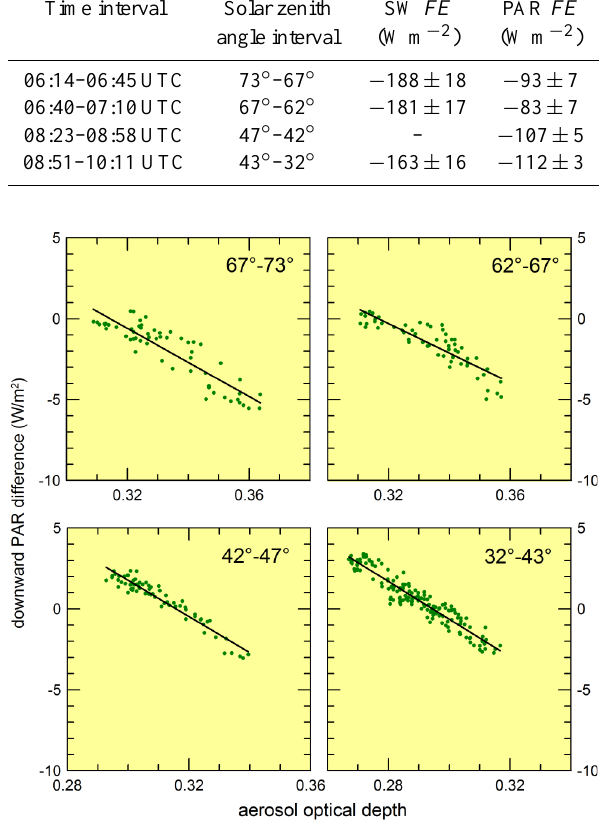
Fig. 5. Deviations of the measured downward PAR irradiance from the estimated PAR irradiance at fixed aerosol optical depth versus the measured aerosol optical depth, in four intervals of solar zenith angle.